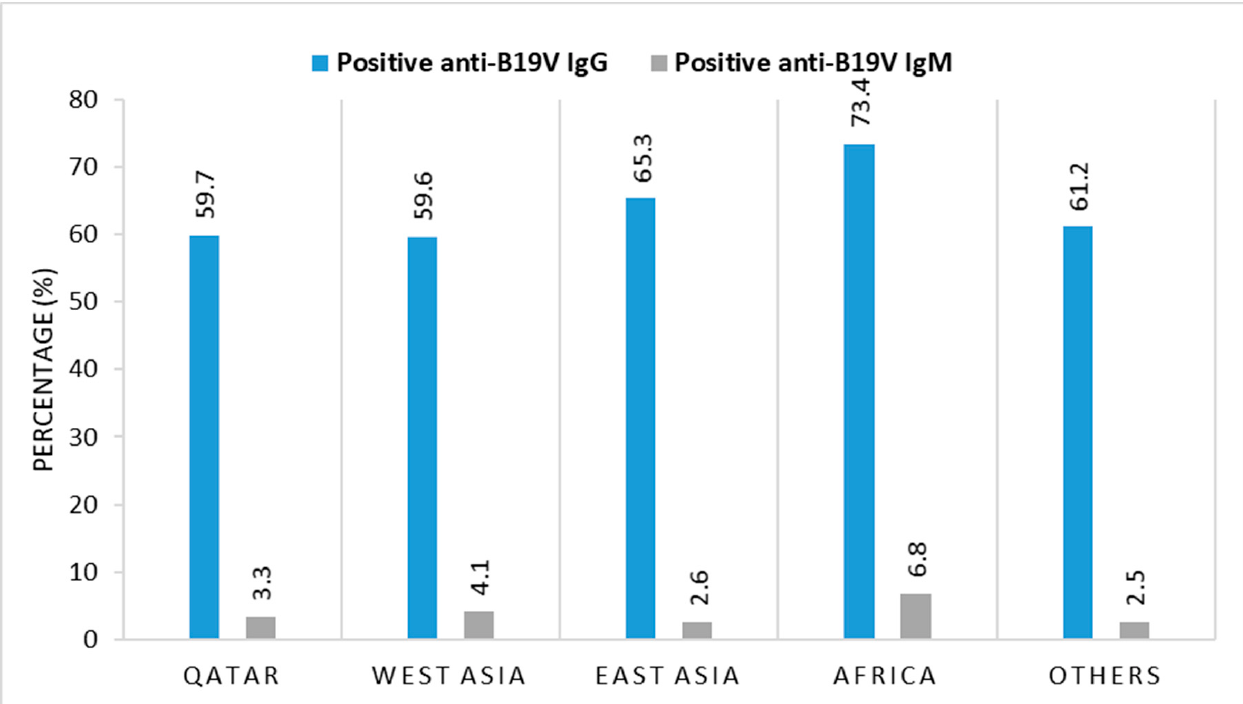
Figure 1. B19V IgG and IgM Seroprevalence among Major Nationalities †West Asia includes the Gulf area: KSA, Kuwait, Bahrain, Yemen, and Oman. ††East Asia includes India, Sri Lanka, Nepal, Bangladesh, Indonesia, and the Philippines.